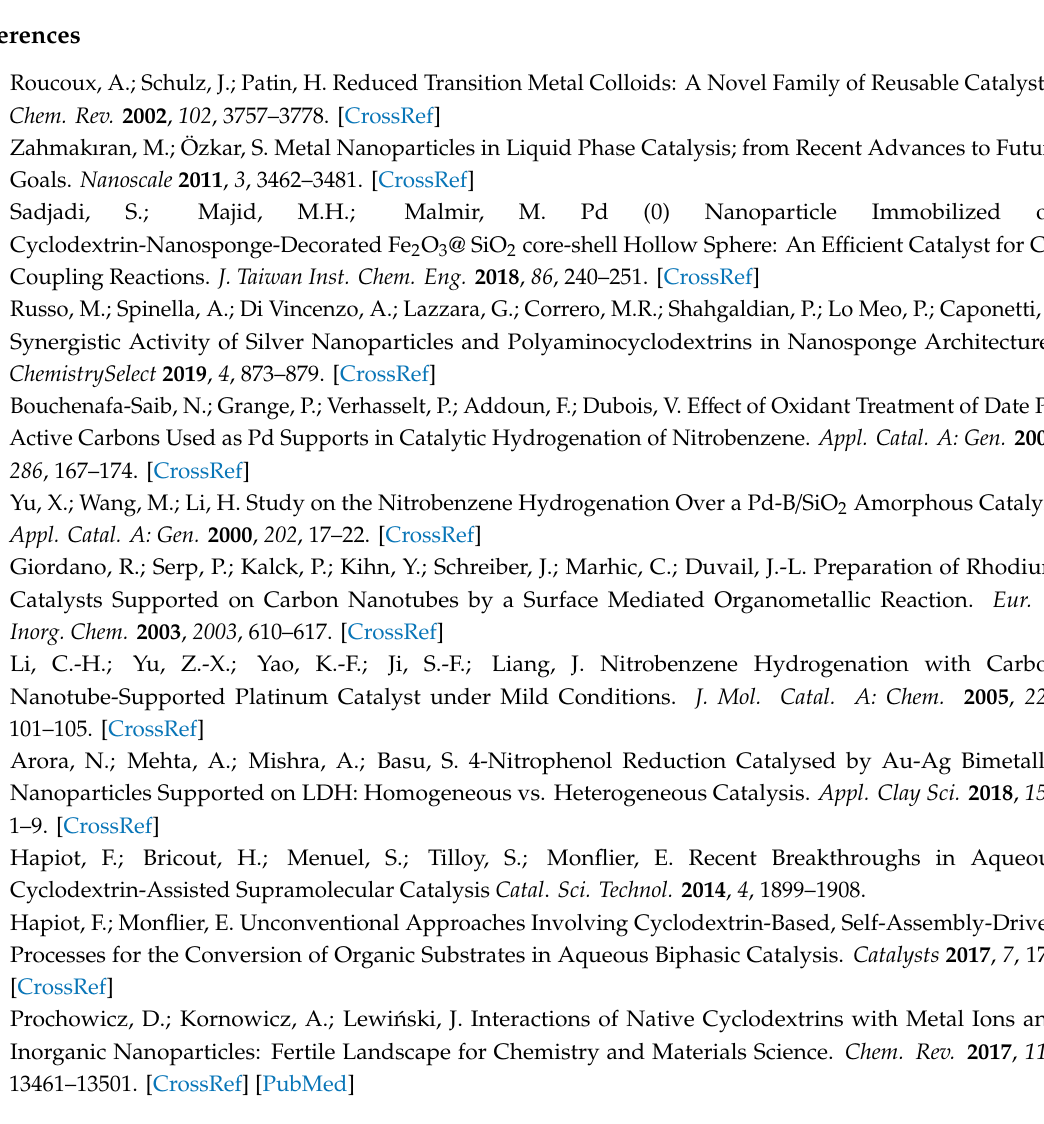
Figure S3. SEM image, EDS analysis and Elemental mapping analysis of CDNS-N /